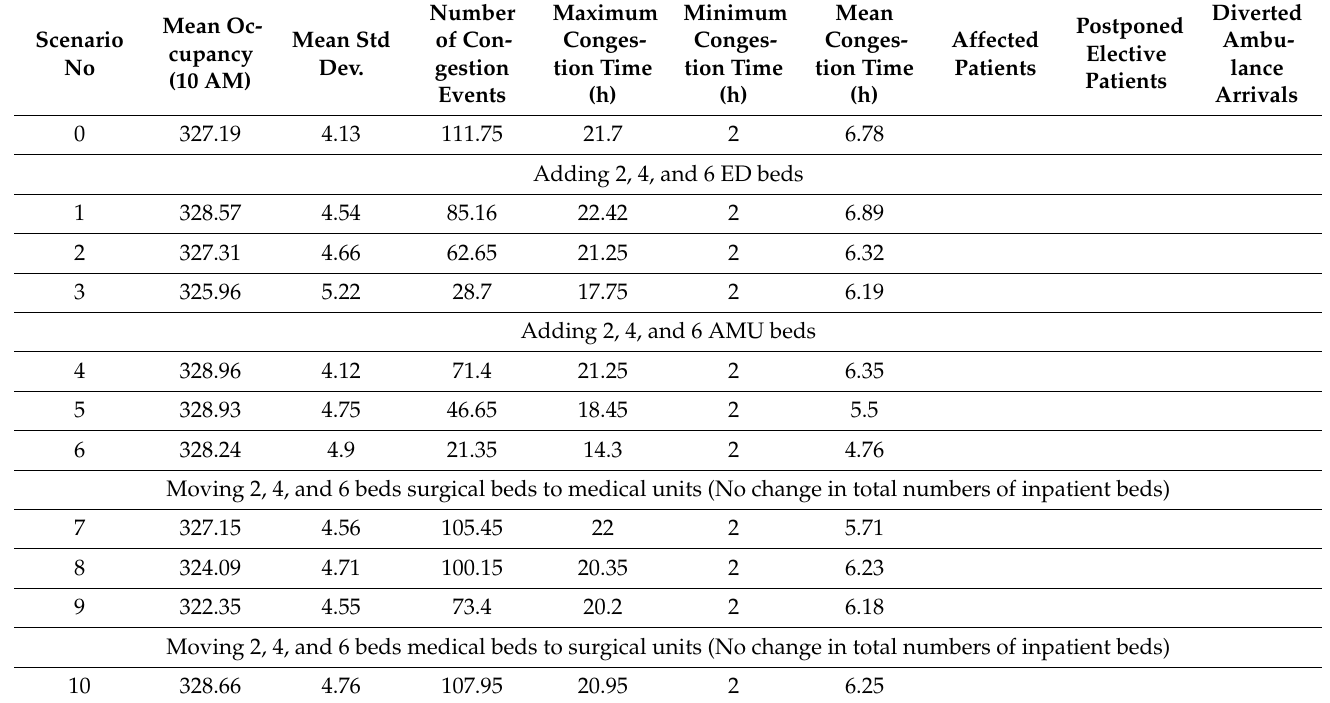
Table 1. Summary results of scenarios (20